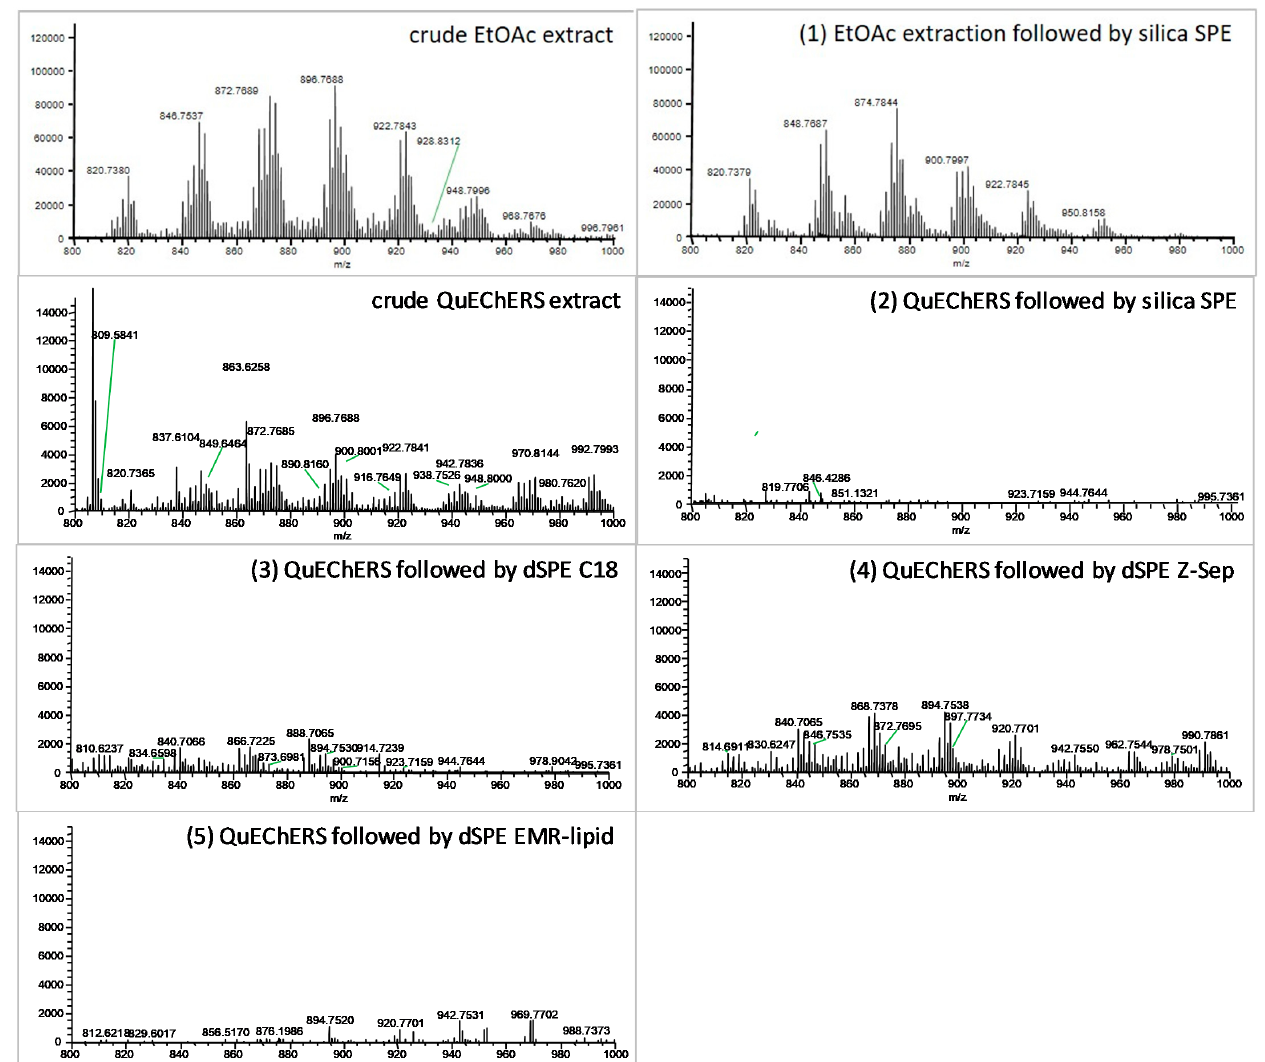
Figure 3. The comparison of TAG removal (scanned mass range m/z 800–1000) between the crude and purified extracts of the smoked trout using different sorbents detected by DART-HRMS.